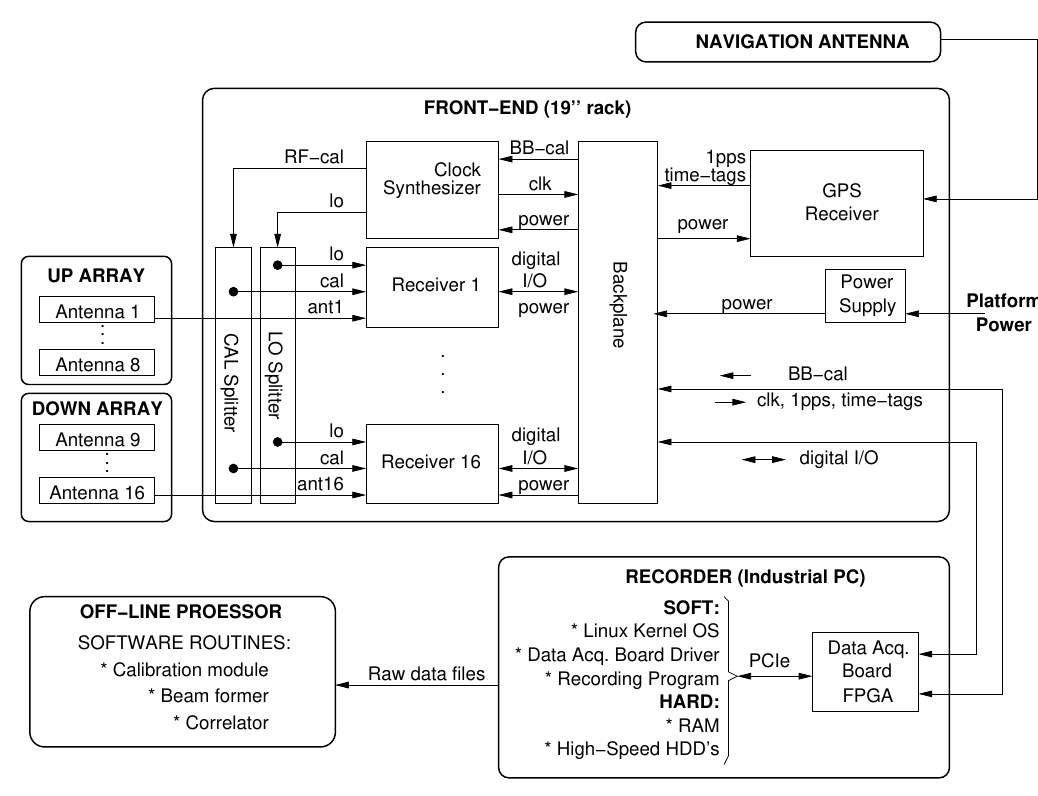
Figure 1. Block diagram of the Software PARIS Interferometric Receiver (SPIR)